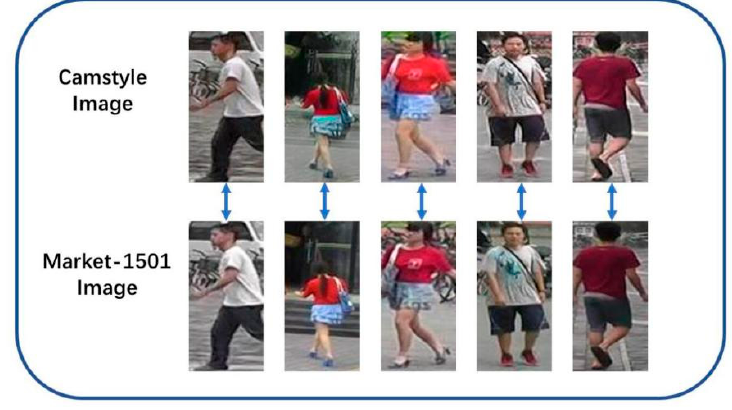
Figure 3. Examples of images generated by Camstyle.